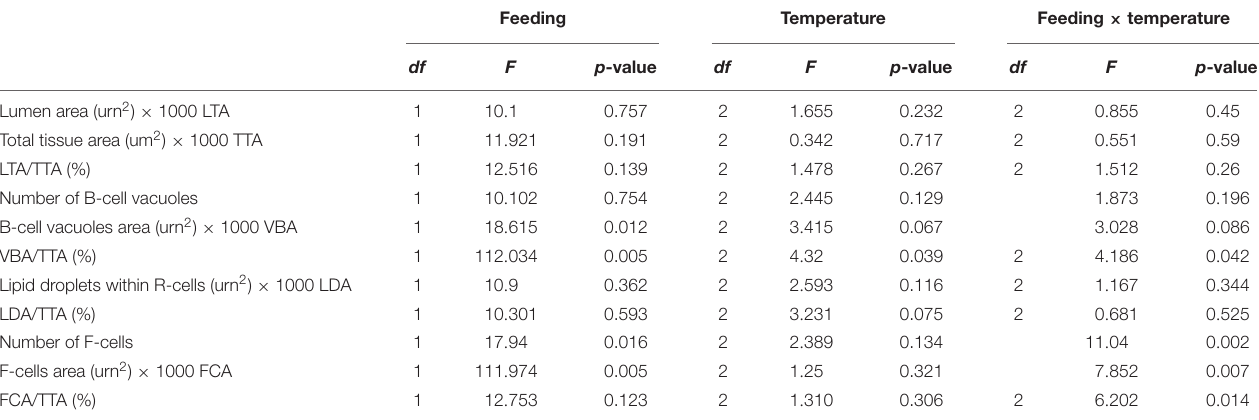
TABLE 9 | t Two-factor ANOVA on the morphometric parameters measured on the hepatopancreas histology preparations of H. gammarus fed and unfed kept at different holding temperatures (4, 8, and 12 ◦ C) after being held in captivity for 24 weeks. Feeding Temperature Feeding × temperature